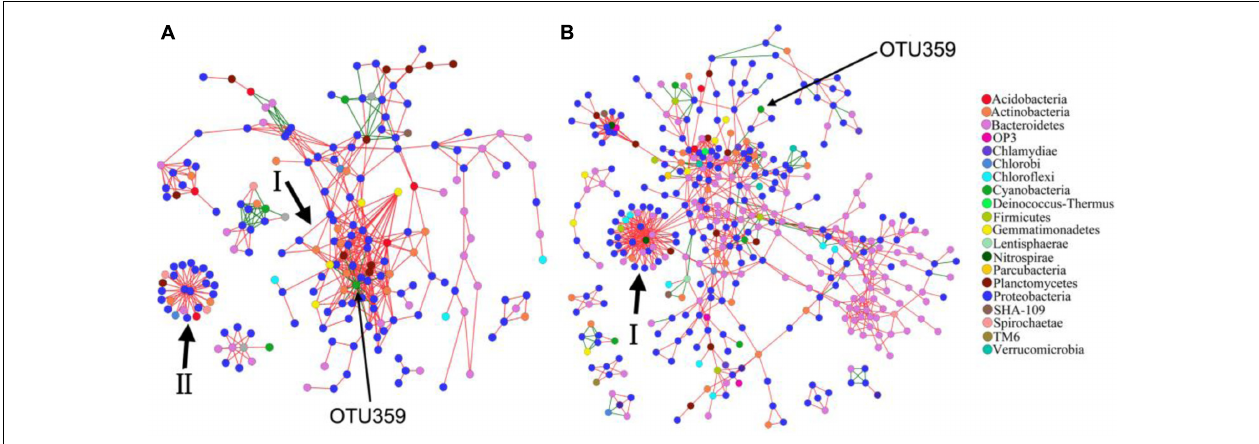
FIGURE 5 | Network interaction of OTUs in PAB (A) and FLB (B) . Node of bloom-causing M. aeruginosa OTU 359 is marked with long arrows, and major modules are marked with short arrows and Roman numerals. Red lines indicate positive interactions, and green lines indicate negative interactions.